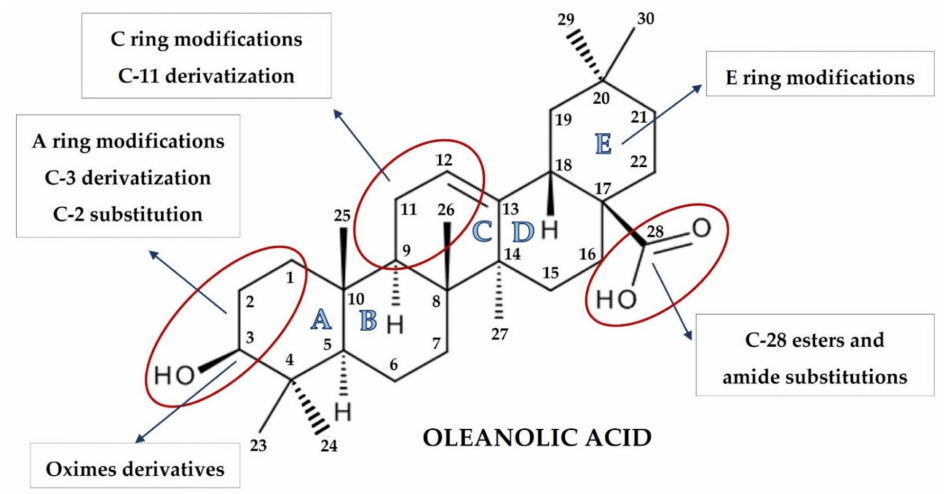
Figure 1. Sites of possible chemical modification of oleanolic acid structure that might lead to increased biological activity. Figure was created with BioRender.com by the